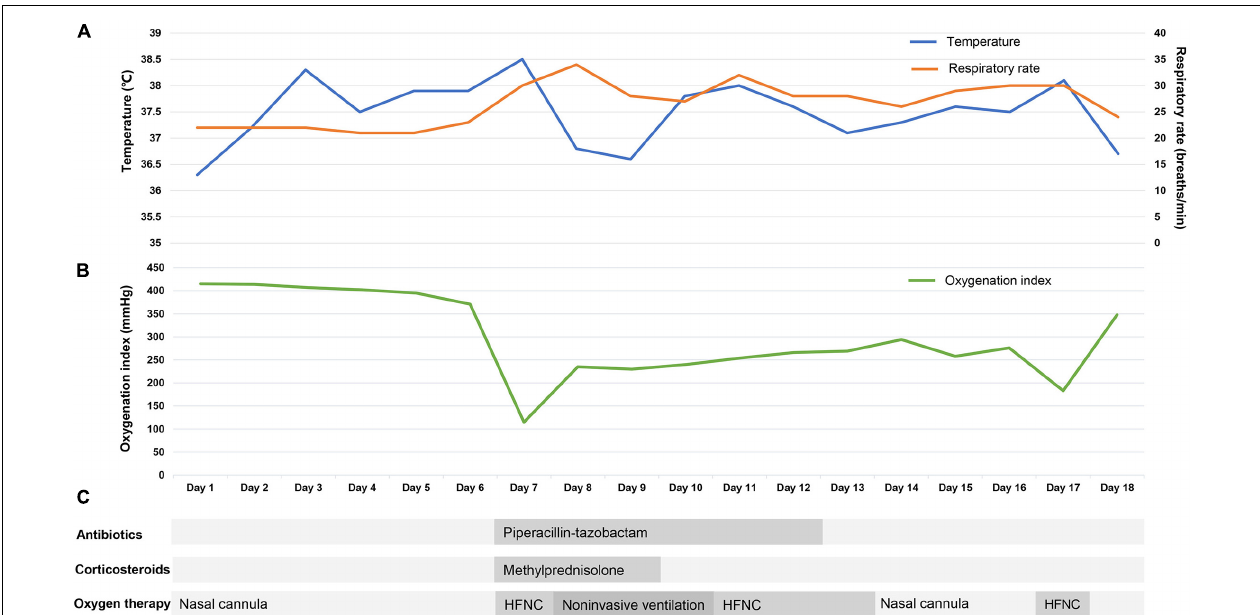
FIGURE 2 | The timeline of essential clinical parameters and management of the patient. The X-axis represents the disease duration of the patient after hospital admission (days). (A) The Y-axis on the left represents the temperature value (blue line), and the Y-axis on the right represents the respiratory rate value (yellow line). (B) The Y-axis represents the oxygenation index value (green line). (C) The antibiotics, corticosteroids, and oxygen therapy of the patient. HFNC, high-flow nasal cannula oxygen